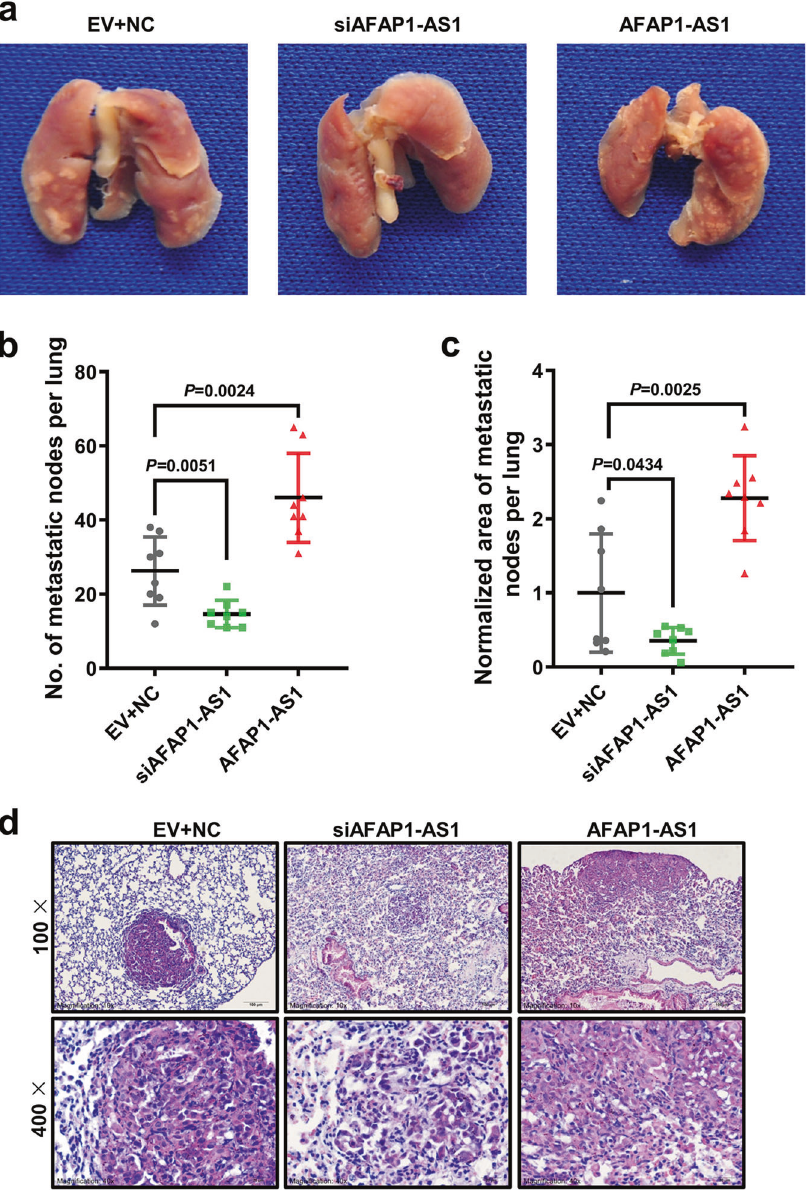
Fig. 2 AFAP1-AS1 promotes lung cancer metastasis. a Representative images of nude mouse lung tissues in three groups: A549 cells transfected with scrambled siRNAs and the empty vector (EV + NC, negative control), the pool of two siRNAs of AFAP1-AS1 (siAFAP1-AS1) or the AFAP1-AS1 overexpression plasmid (AFAP1-AS1) were injected into each nude mouse tail veins ( n = 8 for each group), which were sacri fi ced 8 weeks later. b The metastatic nodules in the siAFAP1-AS1 group were much fewer than that in the EV + NC group, while that in the AFAP1-AS1 overexpression group was obviously more than that in the EV + NC group. c The lung metastatic nodules area on each mouse lung tissue surface. The metastatic area of the siAFAP1-AS1 group was smaller obviously and the AFAP1-AS1 overexpression group was much larger than that of the EV + NC group. Mean ± SD shows for data; n = 8 mice for each group. d Representative pictures of lung metastatic tumor foci after H&E staining (Scale bar: 20 μ m and 50 μ m). Data are presented as the means ±